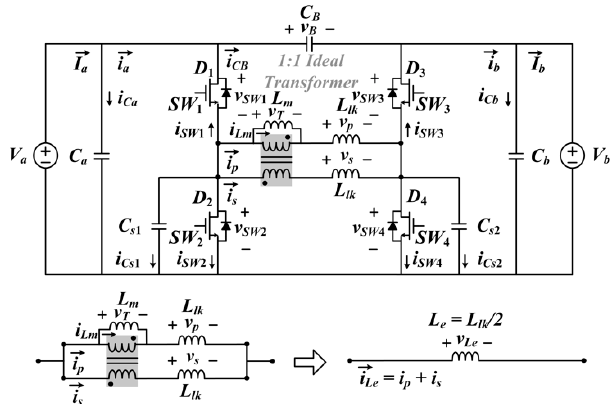
Figure 5. Circuit structure of the proposed CBB BDC.